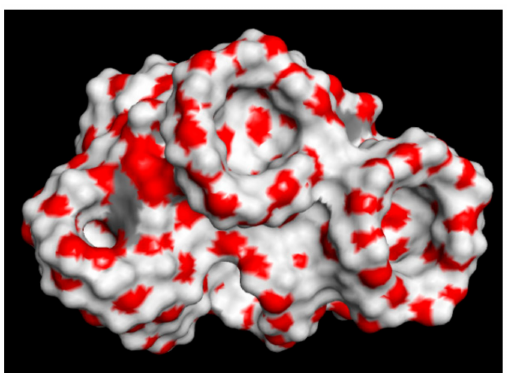
Figure 5. The solvent-accessible surface area of a β -CD NS ( β -cyclodextrin Nanosponge) model with a pyromellitic dianhydride (PMA) crosslinker as reported in Model 2 in [29] colored by atoms. Color codes: C atoms are grey, oxygen atoms re red, and hydrogen atoms are